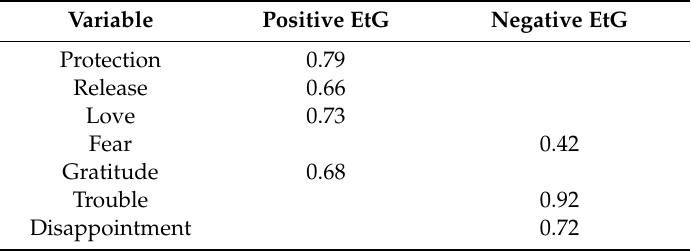
Table 9. Structure of the factors of the emotions towards God for “religious” protestant adolescents and young adults.